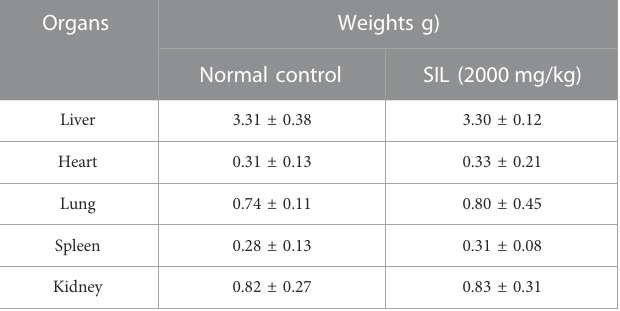
TABLE 2 Estimation of organ weight in treatment groups during acute oral toxicity